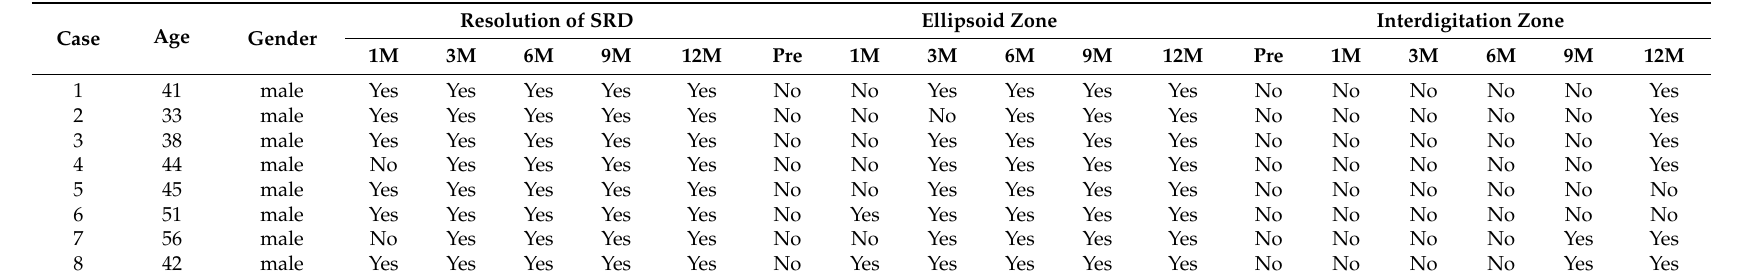
Table 1. Demographics, status of serous retinal detachment, and OCT findings before and after treatment.